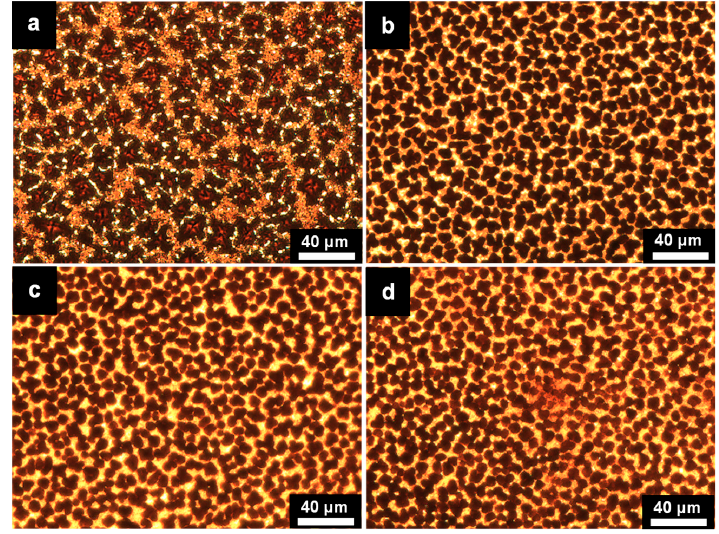
Figure 3. Optical microscope images of the MAPbI 3 /(DPPS) perovskite solar cells. The